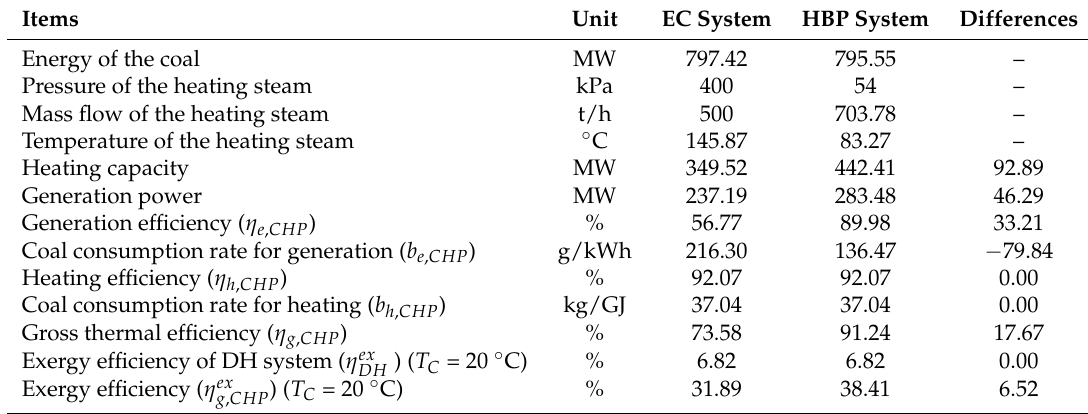
Figure 5. Energy flow of the CHP systems: ( a ) EC system; ( b ) HBP system. Table 5. Thermodynamic performances of the two CHP systems in design